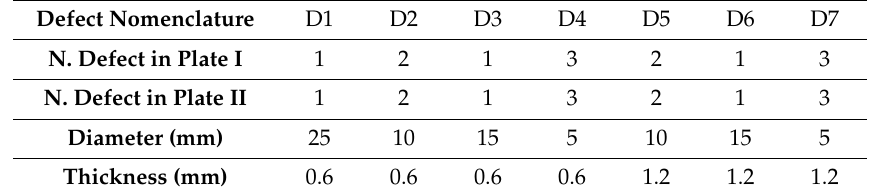
Table 1. Artificial defect geometry in the plates.